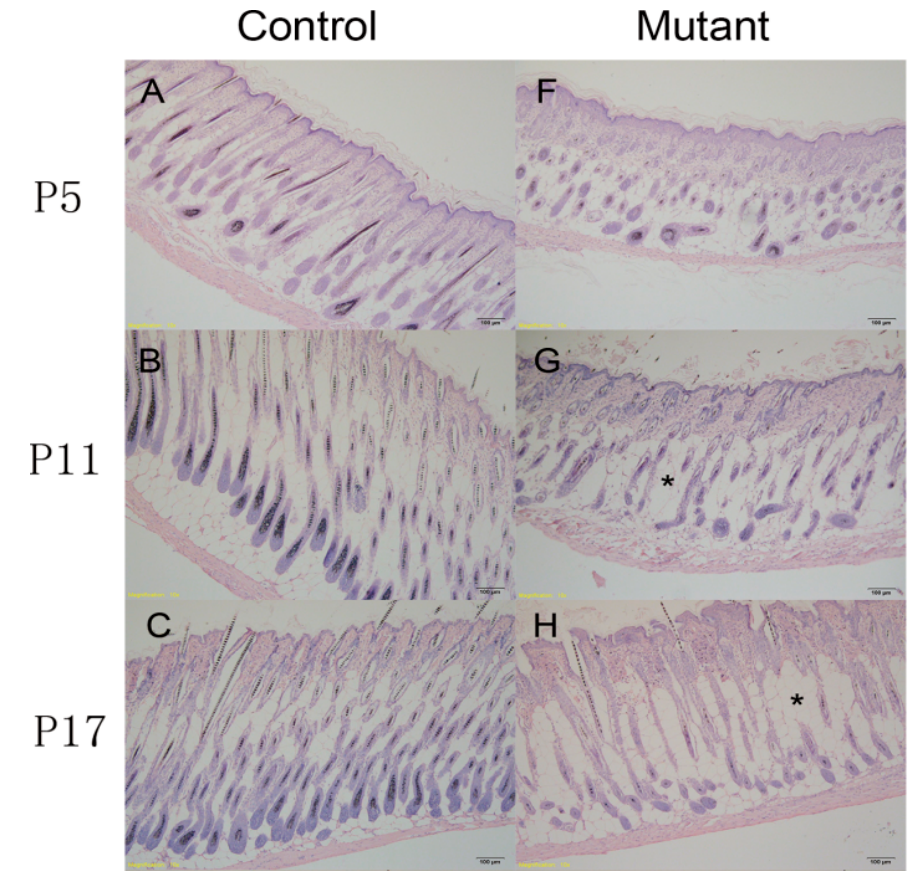
Figure 3. Cont. Figure 3.